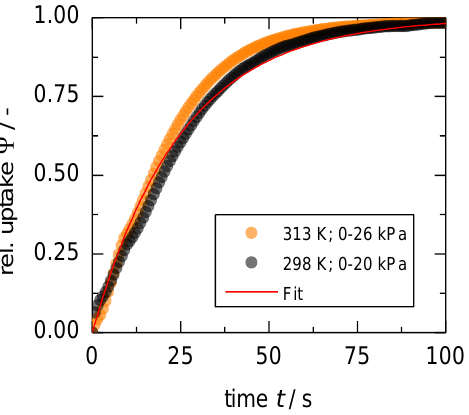
Figure 10. Two uptakes with the same sorption rate coefficient, although the black curve shows the relative uptake at a lower temperature and a smaller pressure step.